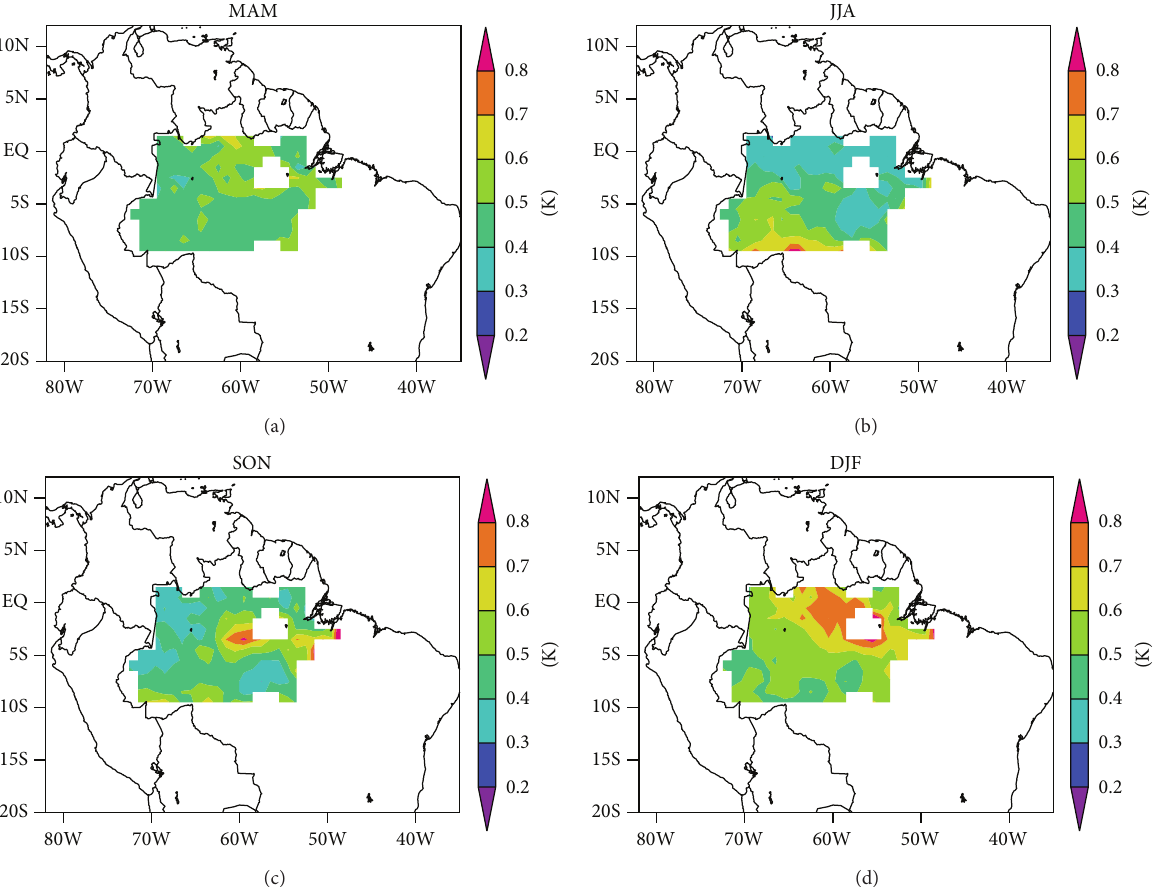
Figure 4: Standard deviation of the remotely sensed LST anomalies at 6:30 a.m. over Amazon rainforests for the following seasons: (a) MAM, (b) JJA, (c) SON, and (d) DJF.